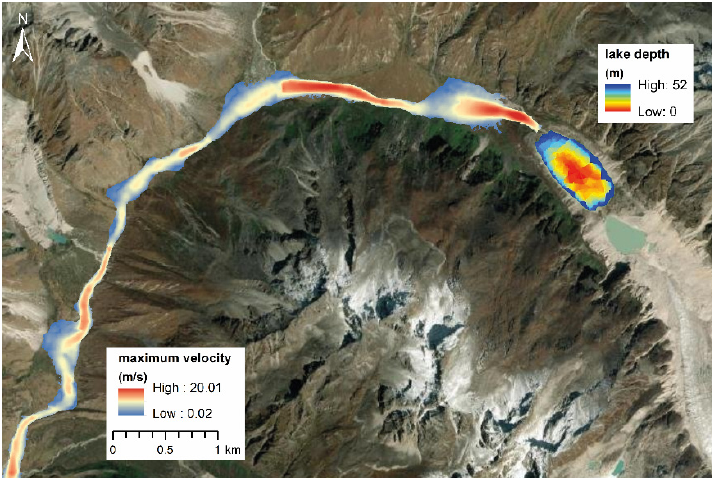
Figure 5. Maximum flow velocity of the worst case scenario in the uppermost section of the GLOF and lake bathymetry (taken from [13], slightly modified). (Source: Esri, Maxar, Earthstar Geographics, USDA FSA, USGS, Aerogrid, IGN, IGP, and the GIS User Community). Some 45 km below the glacial lake, the flood reaches the five bath houses of Gasa Hot Springs (Figure 6), which is a popular site for tourists. These buildings are affected under every scenario, with flood depths between 1 m (best case) and 1.60 m (worst case). Figure 7 shows an inundation map for the most populated Punakha region. Here, more buildings are affected under the worst case and under the average GLOF scenario, but not under the best case scenario, inclding a small commercial or industrial complex of buildings on the outskirts of Punakha (a in Figure 7), two buildings at the Punakha riverfront (b in Figure 7), and one religious place (Thangzona Choelkhang) located 700 m upstream of Punakha Dzong (c in Figure